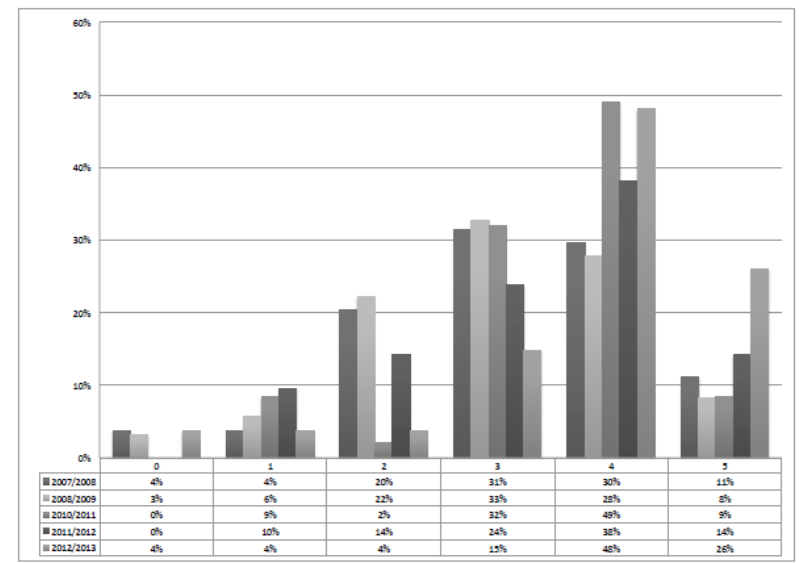
Figure 8. JavaVis did help you to get a beter grasp of the